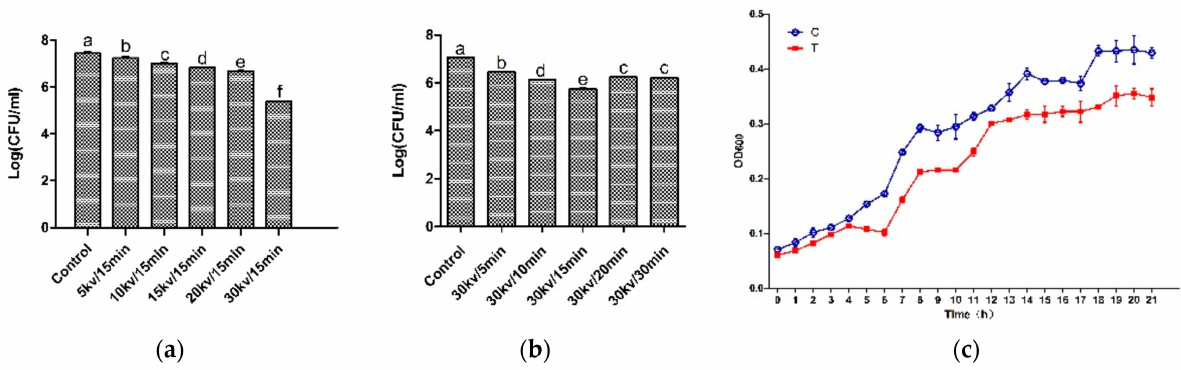
Figure 1. The time–kill assays ( a ), voltage–kill assays ( b ), and the growth curve ( c ) of HVEF against A. johnsonii . C: the untreated samples; T: HVEF-treated samples. Different letters (a–f) indicate significant differences between control and HVEF-treated samples. ( p < 0.05).